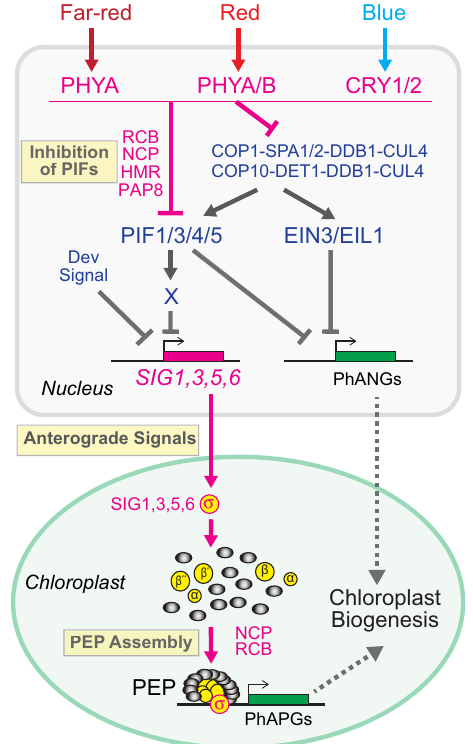
Fig. 9 | Framework of anterograde signaling for the nuclear control of plastid transcription. Monochromaticfar-red,red,andbluelight – whichareperceivedby PHYA, PHYA/PHYB (PHYA/B), and CRY1/CRY2 (CRY1/2), respectively – can indivi- dually initiate anterograde signaling by blocking the accumulation and activity of PIF1, PIF3, PIF4, and PIF5. PHYs and CRYs inhibit PIFs either directly via physical interaction or indirectly by attenuating the activity ofCOP1-SPA- and COP10-DET1- containingCUL4-basedE3ubiquitinligases,whichstabilizePIFsandalsoEIN3/EIL1. PIFs simultaneously repress both PhANGs and PhAPGs via parallel mechanisms. While PIFs work with EIN3/EIL1 to repress PhANGs in the nucleus, PIFs alone separatelycontroltheactivationofthePEPinplastidsbyrepressingtheexpression of four light-inducible SIG s, SIG 1, SIG 3, SIG 5, and SIG 6. PIFs likely repress SIG s indirectly via a yet unknown PIF-induced factor X. During early seedling estab- lishment, anterograde signaling is suppressed by a developmental signal inde- pendently of PIFs. Severaldual-targeted proteins, including RCB,NCP,HMR/PAP5/ pTAC12 and PAP8/pTAC6, participate in the regulation of anterograde signaling in both the nucleus and